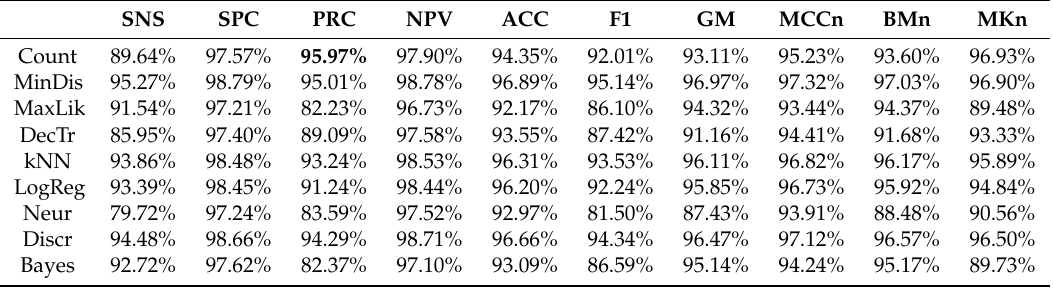
Table 6. Performance metrics classifying the score series obtained by the kNN frame